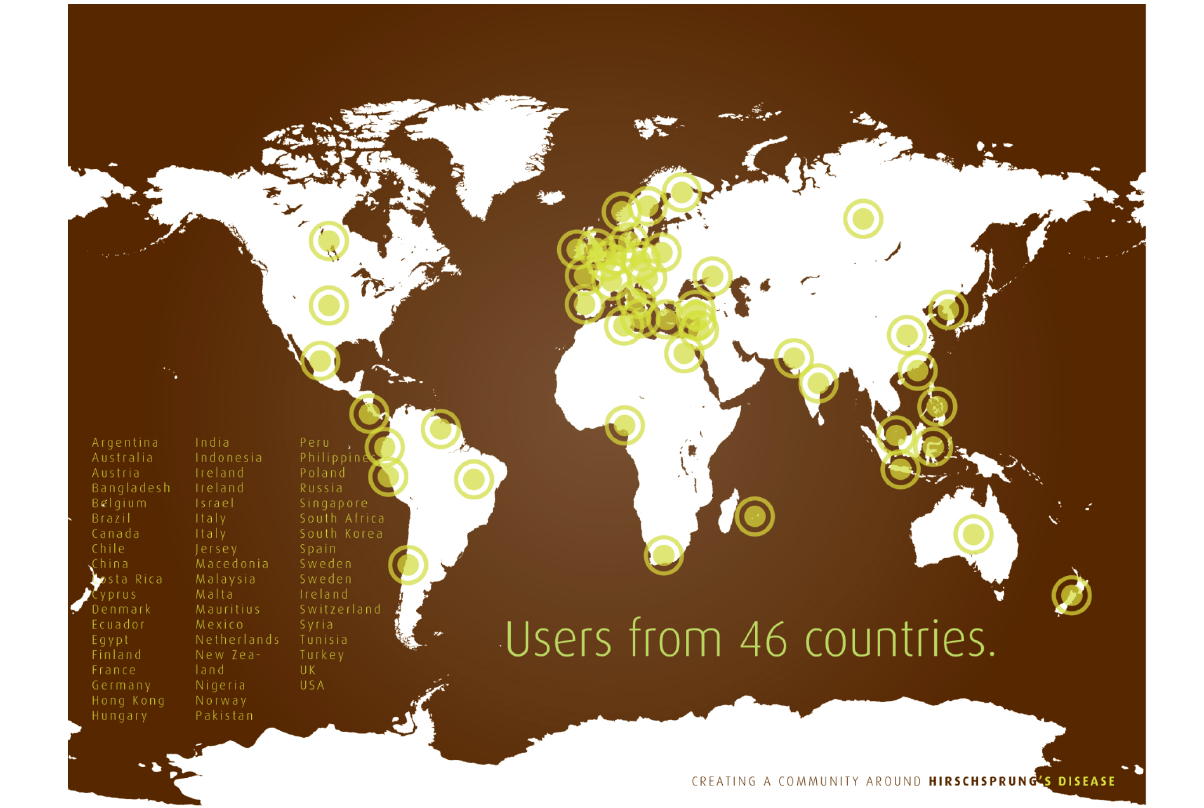
Figure 4. Reach of HD Community Facebook